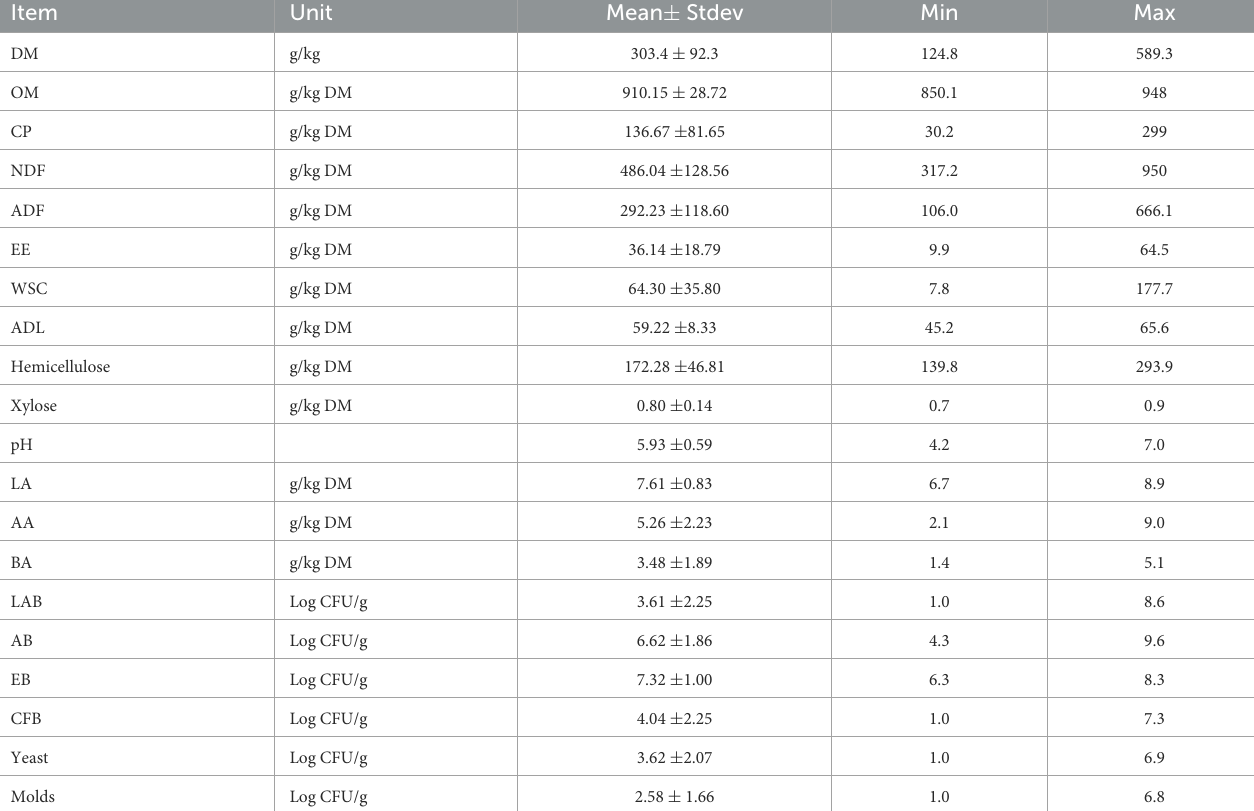
TABLE 4 Descriptive statistics of the substrate prior to the ensiling